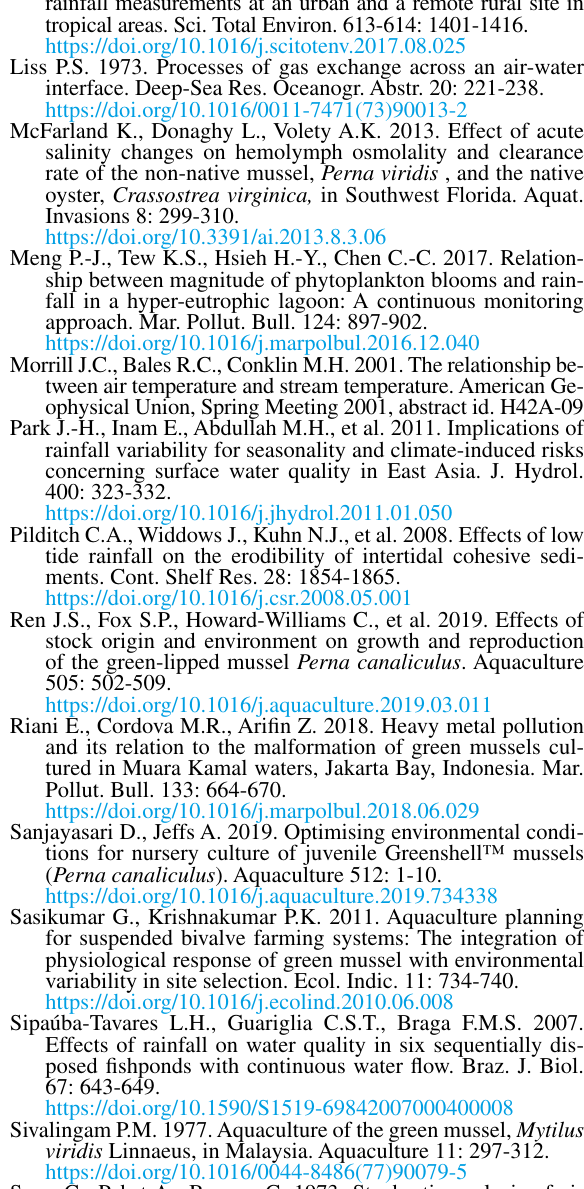
Table S4. – Spatial and temporal variation of green mussel pro- duction and seawater parameters in the mussel cultivation areas at Sriracha (SRI) by using one-way ANOVA and